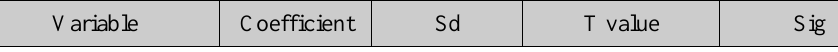
Table 2: estimation of mean